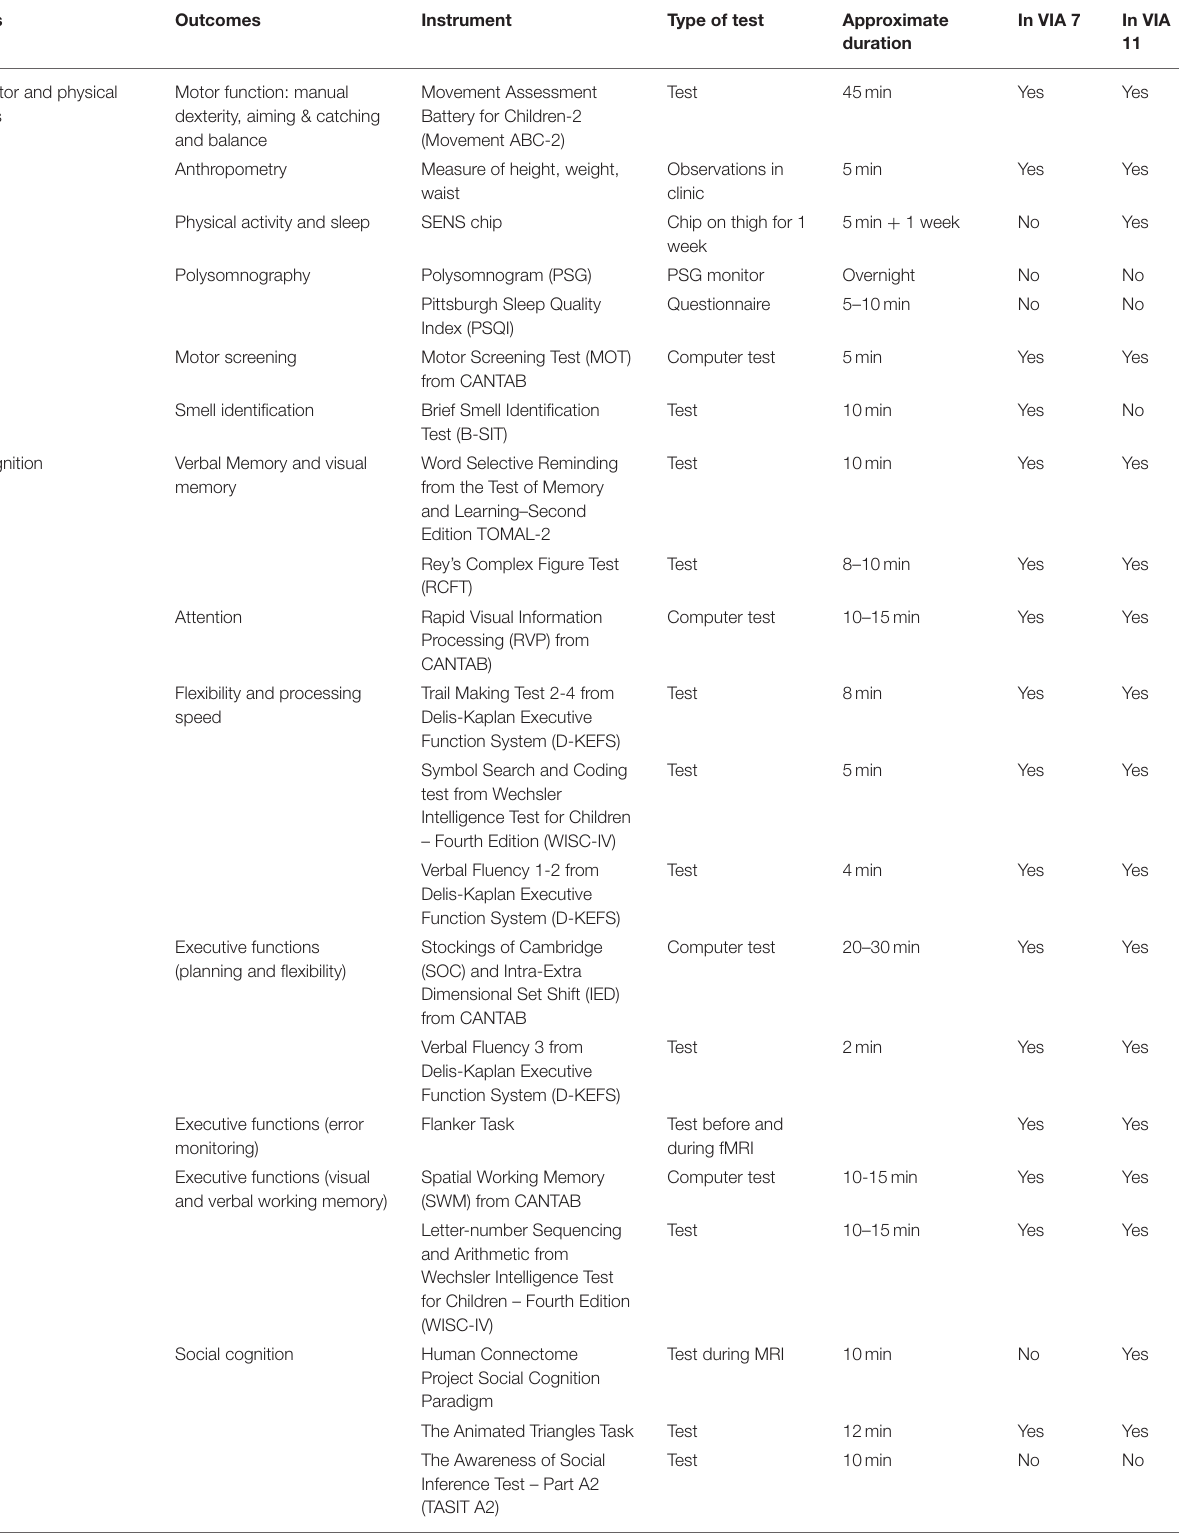
TABLE 1 | Assessment battery for the adolescents in The Danish High Risk and Resilience Study VIA 15, all domains.